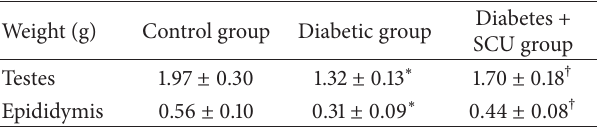
Table 1: Testes weights and epididymal weights of experimental